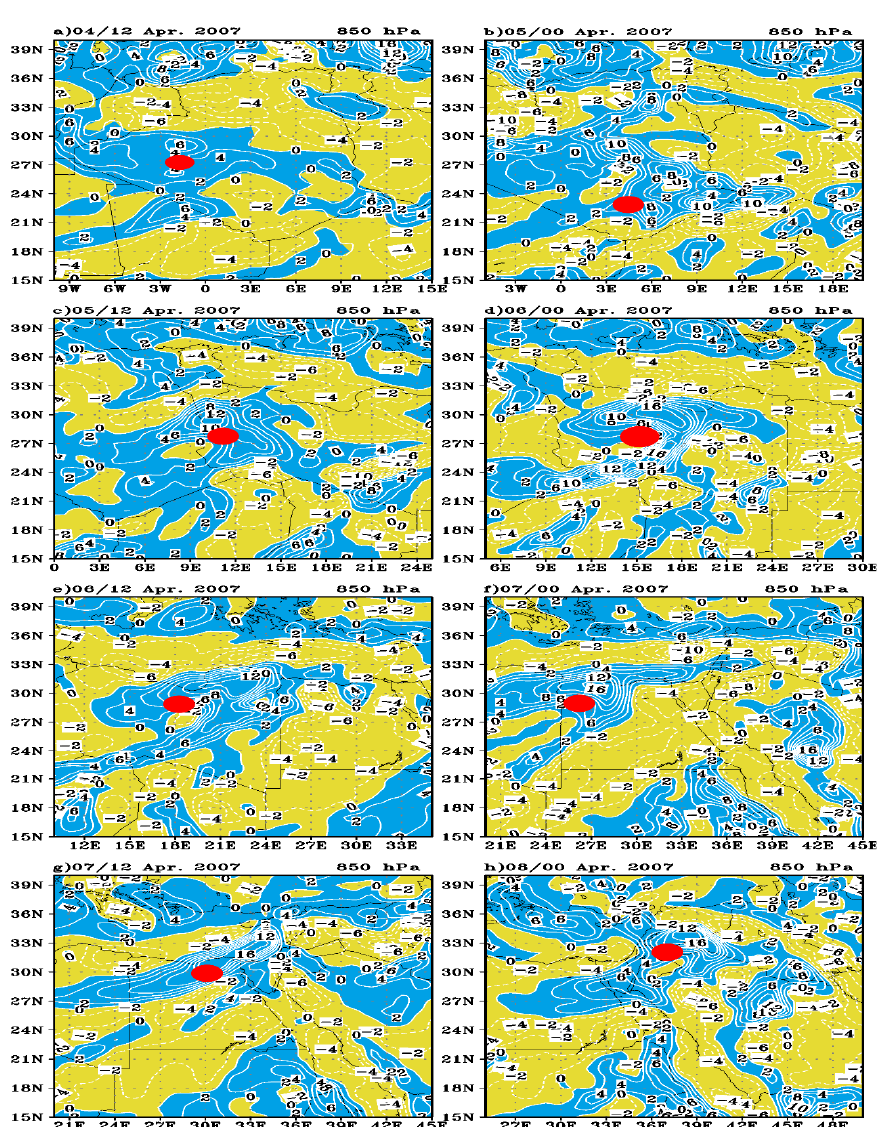
Figure 6. Relative vorticity at 850 hPa contours every 2 × 10 − 4 s − 1 . Solid lines denote positive values, and dashed lines denote negative values. The red-filled circle indicates the maximum absolute vorticity advection at 12Z and 00Z for 4–8 April 2007. (Unit: 10 − 9 s − 2 for maximum absolute vorticity